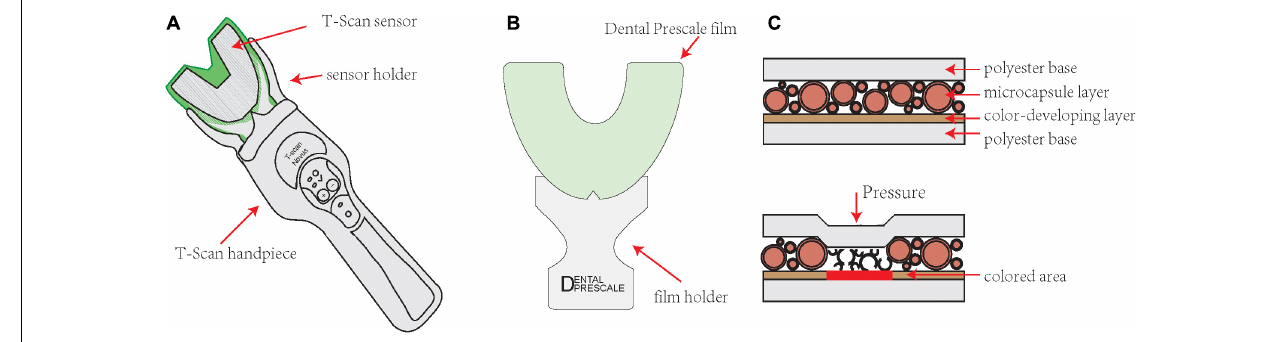
FIGURE 2 | Illustrative figure of the T Scan system (Tekscan, Inc., South Boston, MA, United States) sensor and Dental Prescale system film. (A) A T-scan sensor is shaped to fit the dental arch. There are control buttons on the handpiece, which is convenient for doctors to operate. (B) A dental prescale system film is shaped to fit the dental arch. (C) The dental prescale system film is comprised of two polyethylene terephthalate films and many microcapsules containing color-forming materials between them. When the bite force is applied, the microcapsules collapse, and the color former contained in the capsule leaks out to react with the developer and form a red